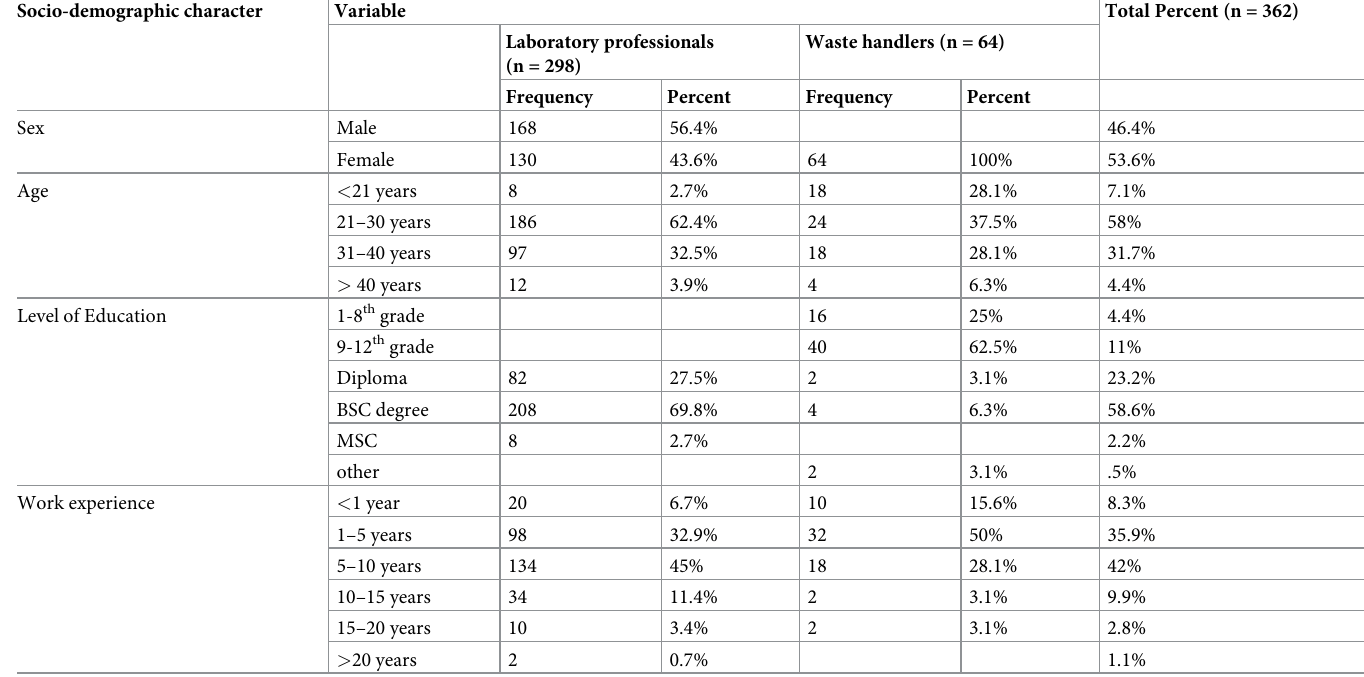
Table 1. Socio-demographic characteristics of study participants in Addis Ababa, Ethiopia (n = 362). Socio-demographic character